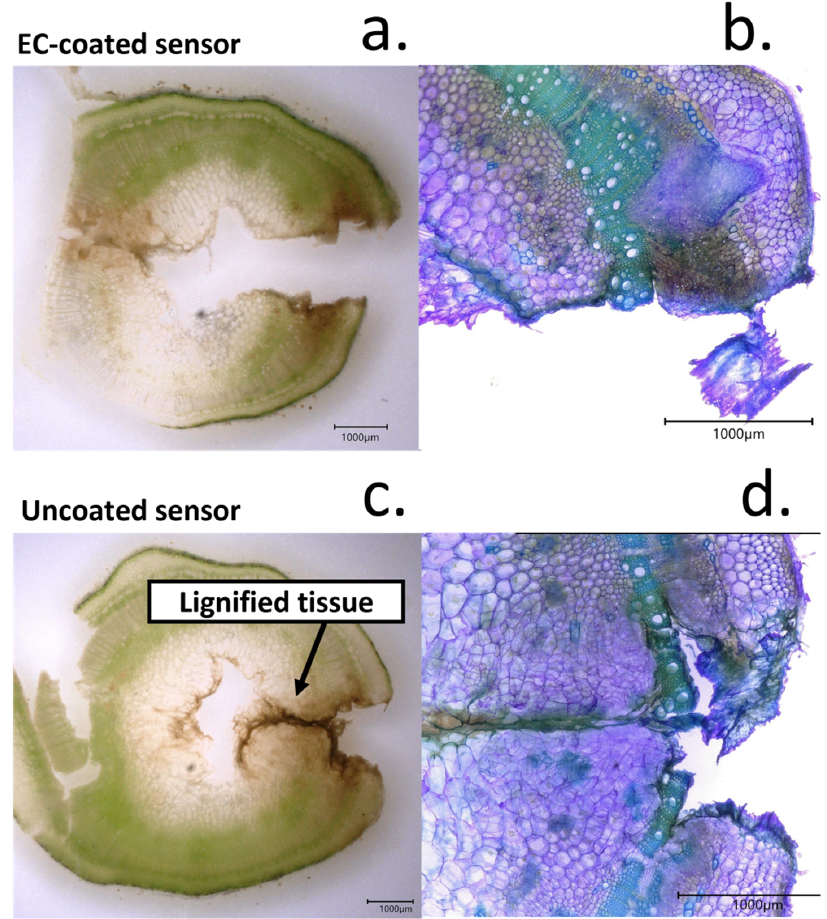
Figure 9. ( a ) Picture of stem cross ‐ section after implantation of pH ‐ sensing electrodes coated with EC/PDMS for 1 week. Brown areas due to the formation of necrotic tissue around the wound area are visible. ( b ) The tissue response from the plant could be imaged by microscopy using Toluidine Blue O stain. This cross ‐ section image was taken from the picture observed in a and evidenced the changes in tissue morphology due to the electrode implantation. ( c ). Picture of tomato stem after the implantation of a cellulose ‐ coated sensor. ( d ) Characterization of tissue responses to exposure of uncoated sensors, only containing RuO x nanoparticles by microscopy.